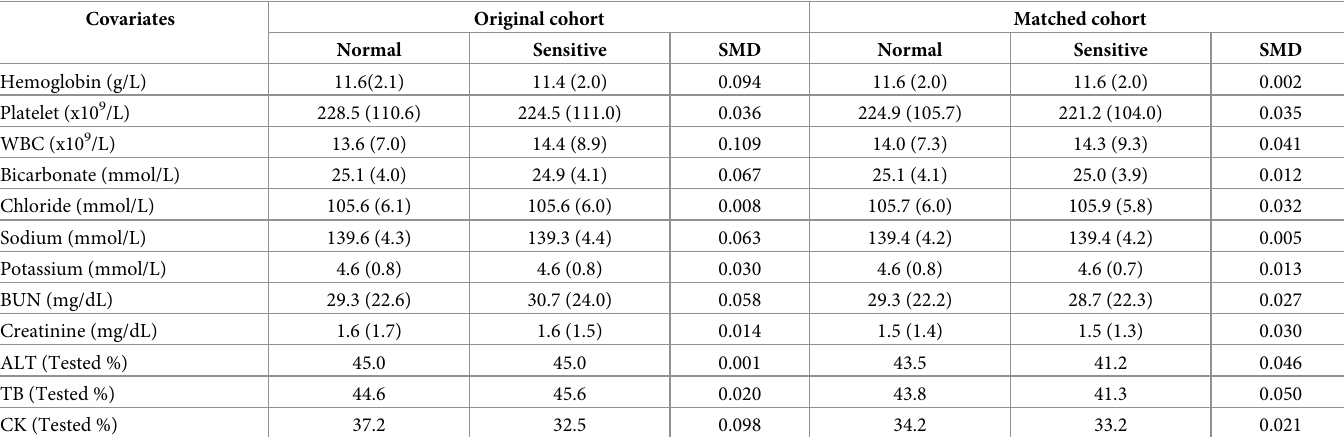
prediction classifiers using the derivation data set from the IWPC cohort. There was no statis- tically significant difference between the derivation and validation data set (S2 Table). The maximal predictive performance evaluated with the validation data set was obtained with the logistic regression (AUC = 0.868) and SVC (AUC = 0.868), followed by NN (AUC = 0.864) and LGBT (AUC = 0.857), and AB (AUC = 0.853) (Fig 2). The algorithms RF, ET, GNB and KNN resulted in the least favorable results (Fig 1). To obtain robust results, the model perfor- (AUC = 0.879, 95% CI: 0.834–0.924; Accuracy = 0.754, 95% CI: 0.649–0.859; F1 score =